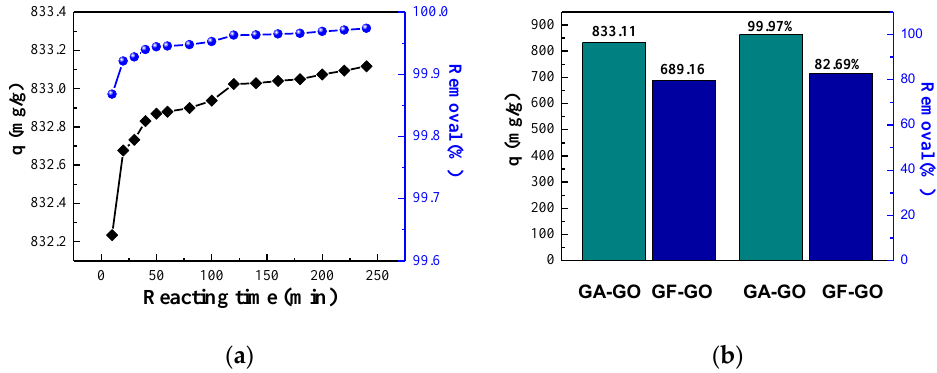
Figure 5. ( a ) Effect of reaction time on adsorption. ( b ) The comparison of the adsorption capacity of GO, where the GA-GO and GF-GO are GO prepared by GA and commercial graphite flakes, respectively.